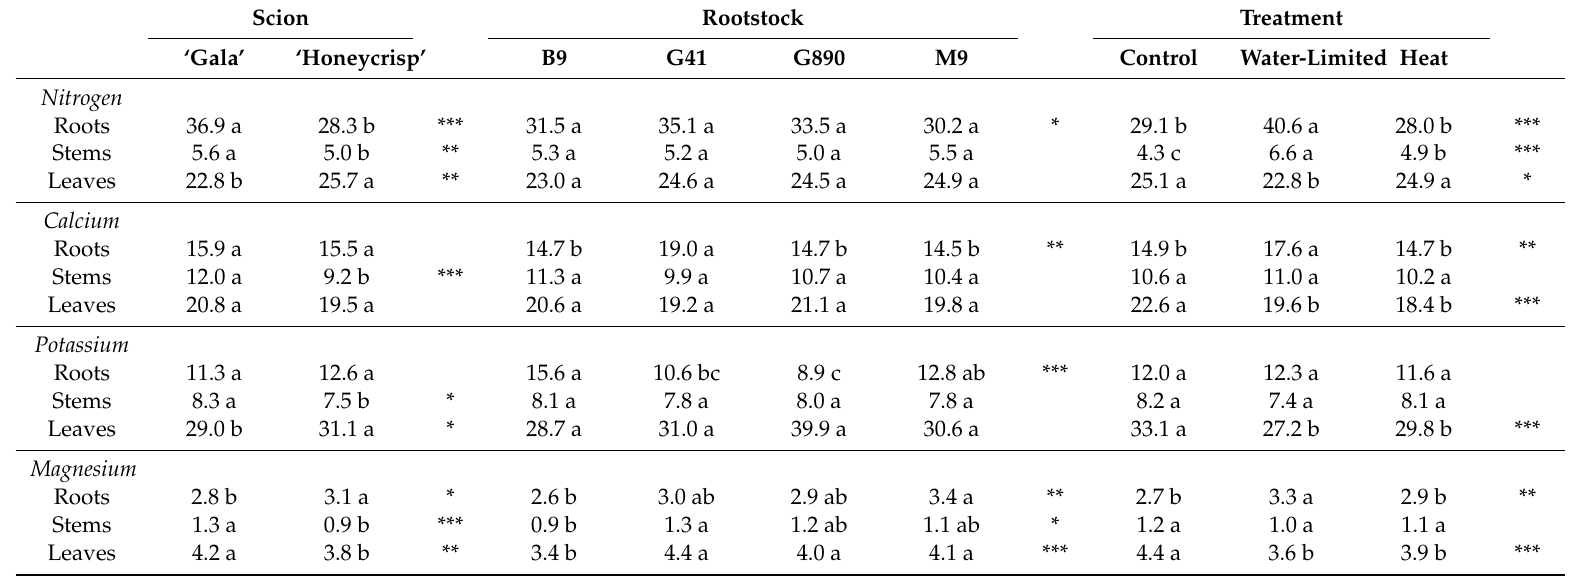
Table 2. Nitrogen, calcium, potassium, and magnesium concentration (mg / g) for roots, stems and leaves of ‘Gala’ and ‘Honeycrisp’ scion genotypes in combination with B9, G41, G890, and M9 rootstocks genotype grown in untreated control, water-limited, or elevated soil temperature treatments. Di ff erent letters denote significant di ff erences among columns determined using a Tukey’s mean separation test ( α = 0.05). ***, ** and * indicate significance in di ff erences among means at p -values < 0.0001, < 0.01 and < 0.05,